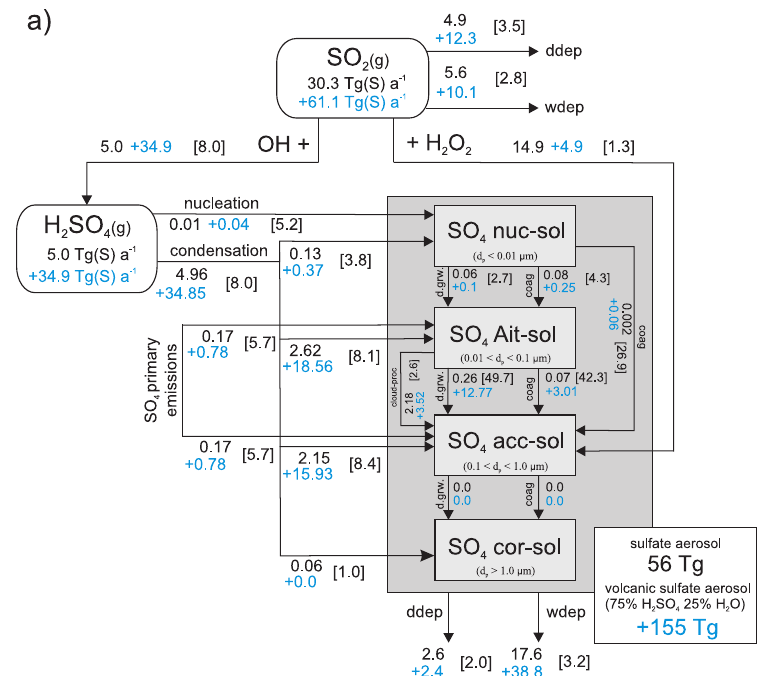
Fig. 4a. Simulated global 12-month mean sulphur budget showing fluxes in Tg(S)a − 1 with blue colours showing absolute changes for L-s, black colours showing the unperturbed run, and ratio of L-s to unperturbed in parentheses. Abbreviations: ddep=dry deposition; wdep=wet deposition; d.grw=direct growth; coag=coagulation; cloud-proc=cloud processing of Aitken mode-sized particles.